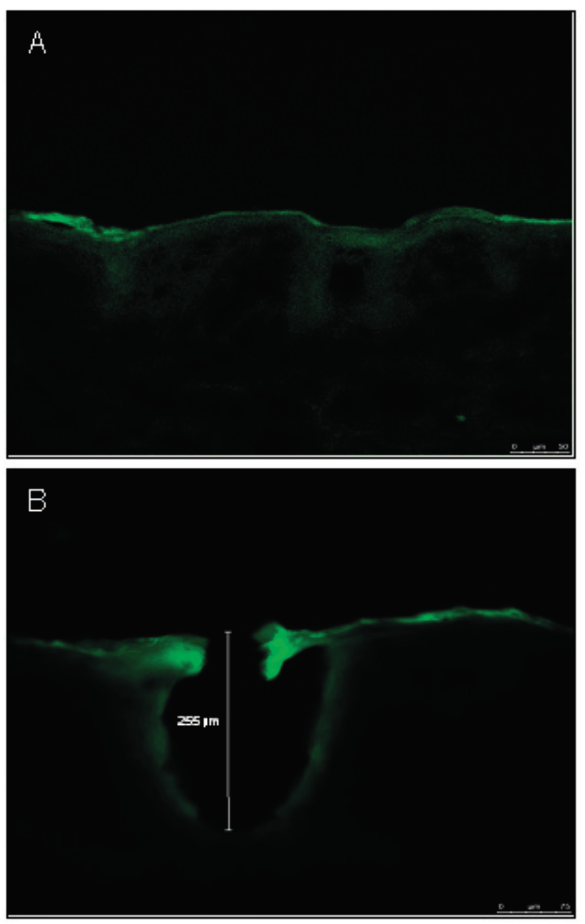
Figure 3. Representative depth of a single microchannel by confocal laser scanning microscopy (CLSM). ( A ) Untreated porcine skin. ( B ) Microneedle treated porcine skin showing a microchannel depth of 255 μ